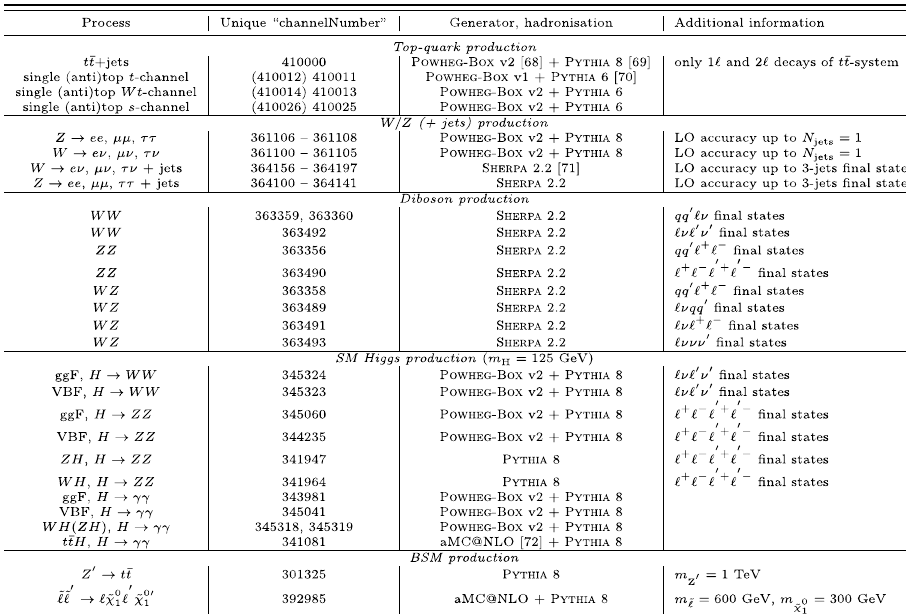
Data. The other BSM samples are on their way to be released. Table 1. Description of the MC samples released in the 13 TeV ATLAS Open Data taken from [10], where the references to the various generators in the table can also be